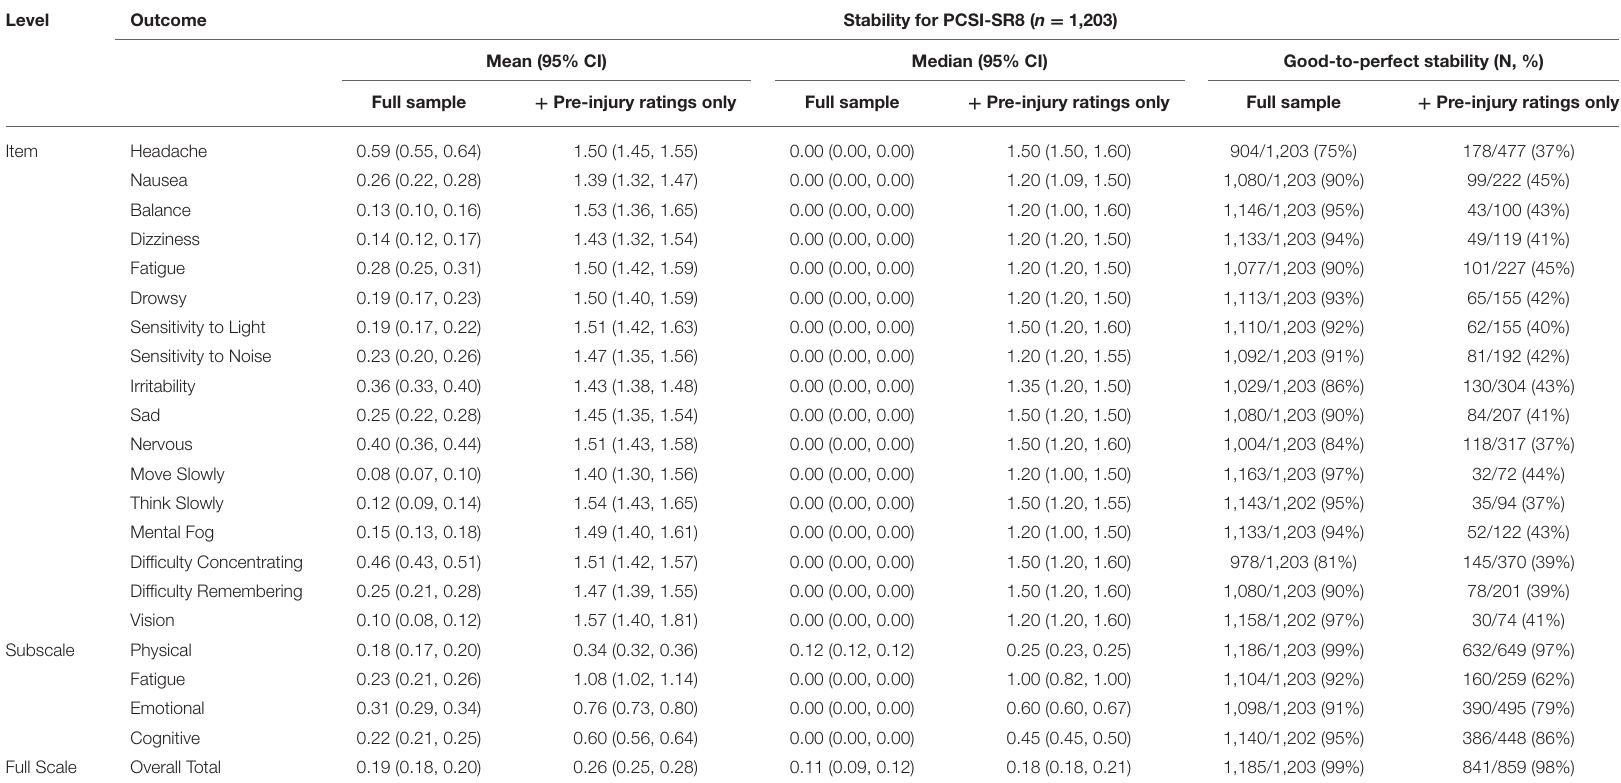
TABLE 4 | Mean (95% CI), median (95% CI), and percentage of individuals with good-to-perfect stability for the PCSI-SR8 (Ages